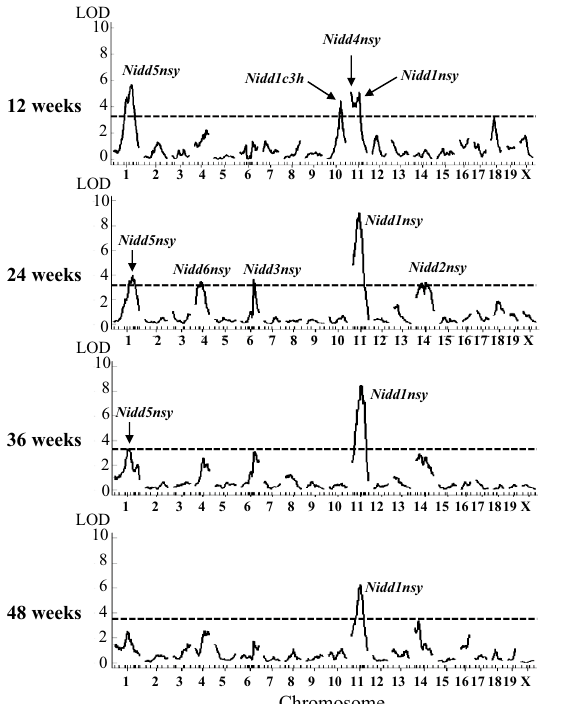
Figure 1. Logarithm of odds (LOD) score curves for the area under the glucose curve (gAUC) after glucose challenge at 12, 24, 36, and 48 weeks of age. LODs were calculated using the R/qtl package. The x-axis represents chromosome positions from the centromere; the y-axis shows LOD scores. The dashed line in each graph represents the threshold LOD value obtained from multiple imputation approach at α = 0.05 by applying 1000 permutations for each trait. These values were 3.21, 3.33, 3.24, and 3.28 for 12, 24, 36, and 48 weeks of age, respectively.